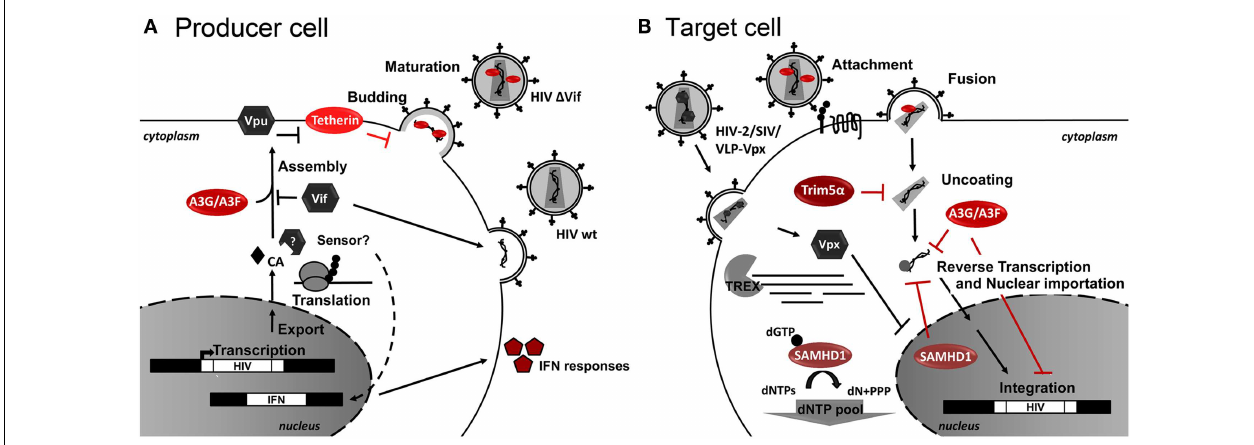
and viral counterpartners are represented by gray hexagons. Black arrows represent the course of viral replication and actions. Broken arrows represent inhibition. Question marks (?) represent unresolved